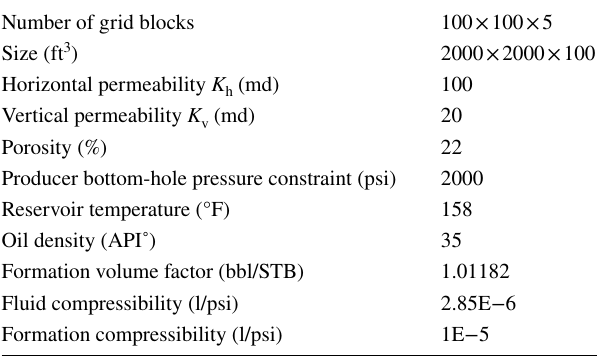
Table 4 Average reservoir and fluid properties in case III and later